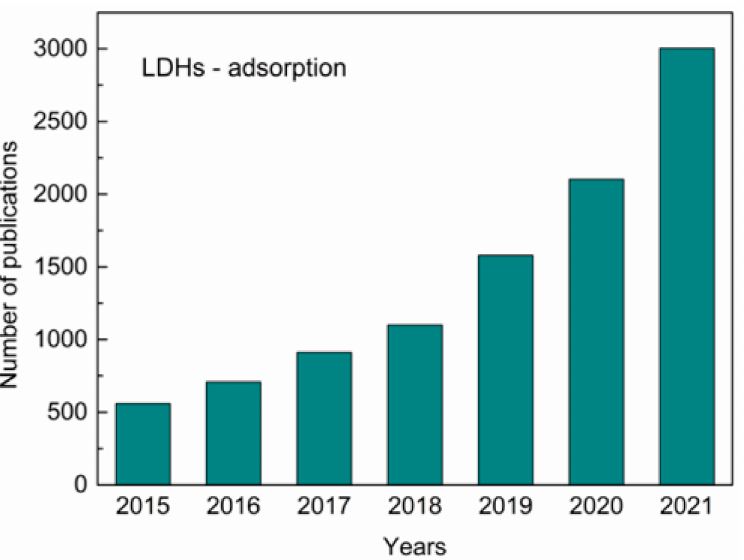
Figure 1. Recent scientific publications using “layered double hydroxide” and “adsorption”, respec- tively, as keywords based on the database of Web of